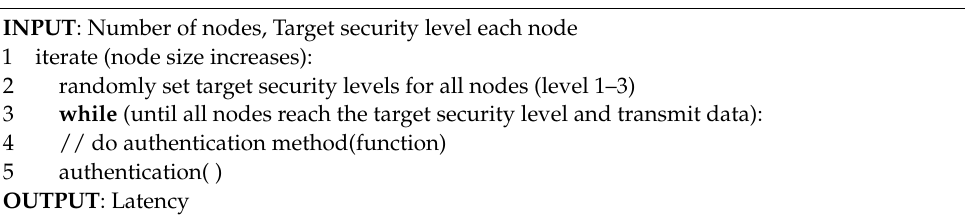
Algorithm 1. Pseudo code for DAM4SNC